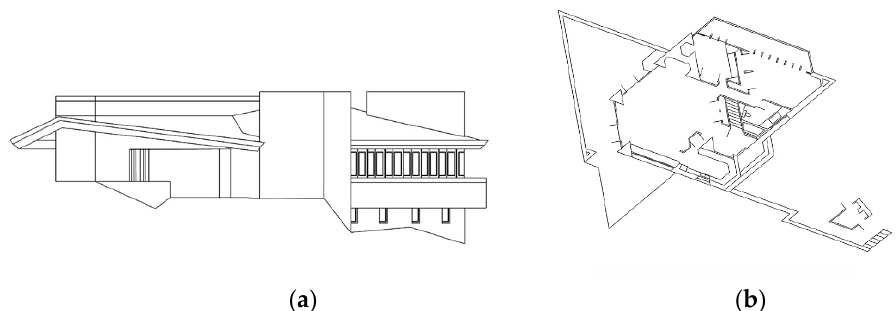
Figure 4. Reisley House (1951), a typical example of Wright’s Triangle ‐ plan Usonian houses. ( a ) Elevation ( b ) plan.